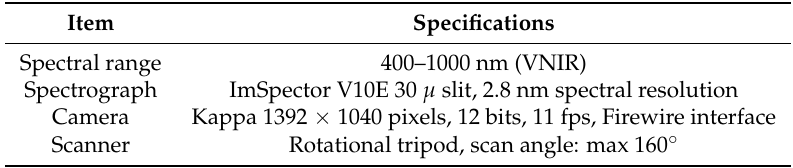
Table 1. Specifications of the hyperspectral image acquisition